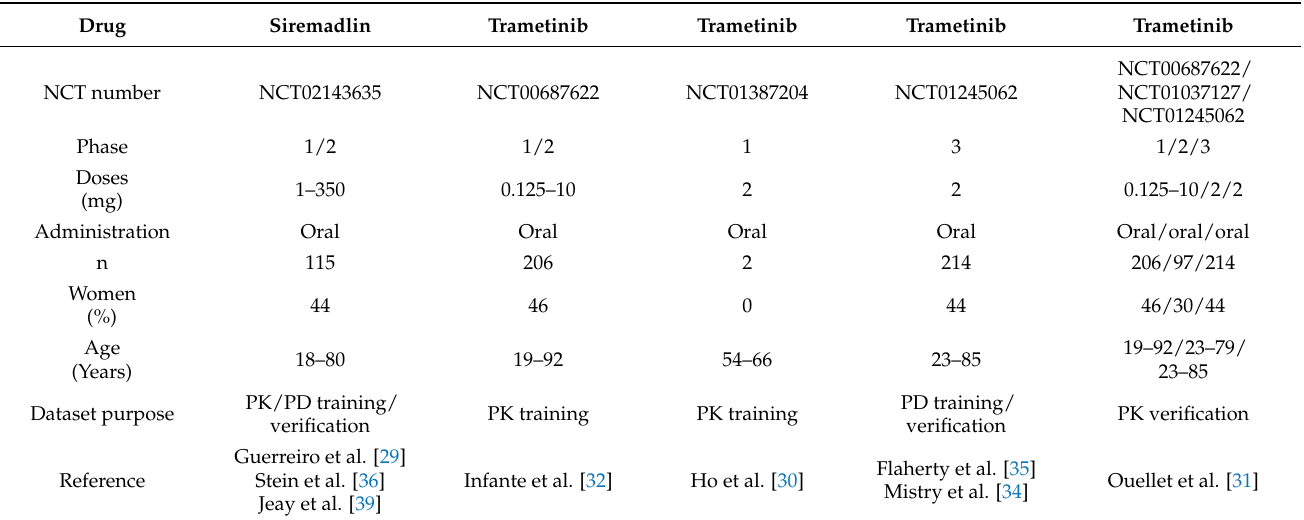
Table 6. Details of the clinical studies used for the development and verification of the siremadlin and trametinib PBPK